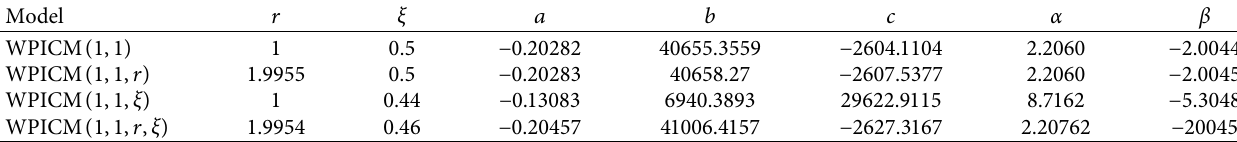
Table 3: Parameters of the prediction model.